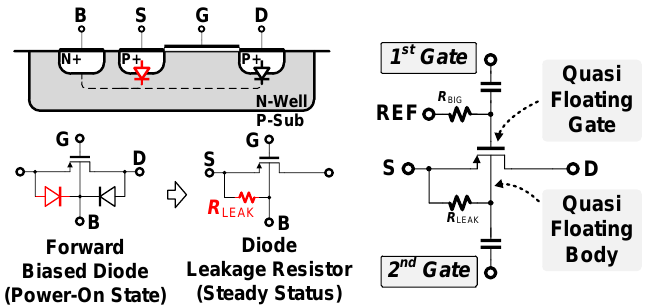
Figure 3. Double-gated PMOS transistor where the gate and body terminal are used as two inputs.